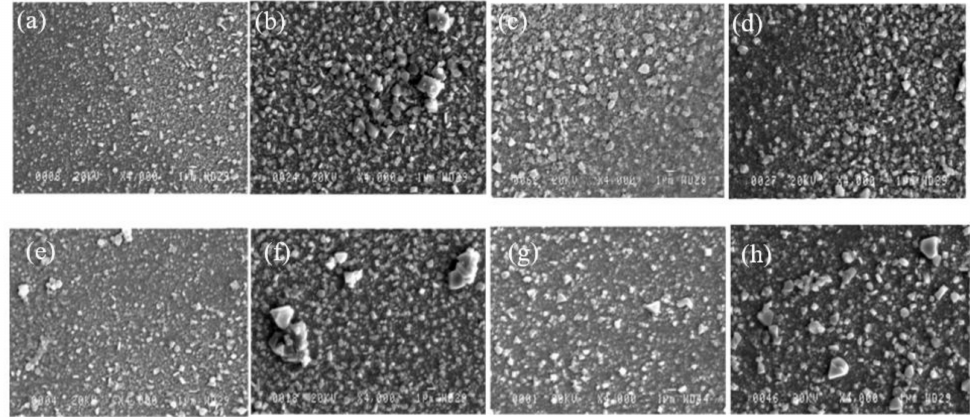
Figure 9. SEM details of 316L ( a – d ) and 316LN ( e – h ) SS plate samples with different FPD exposure.